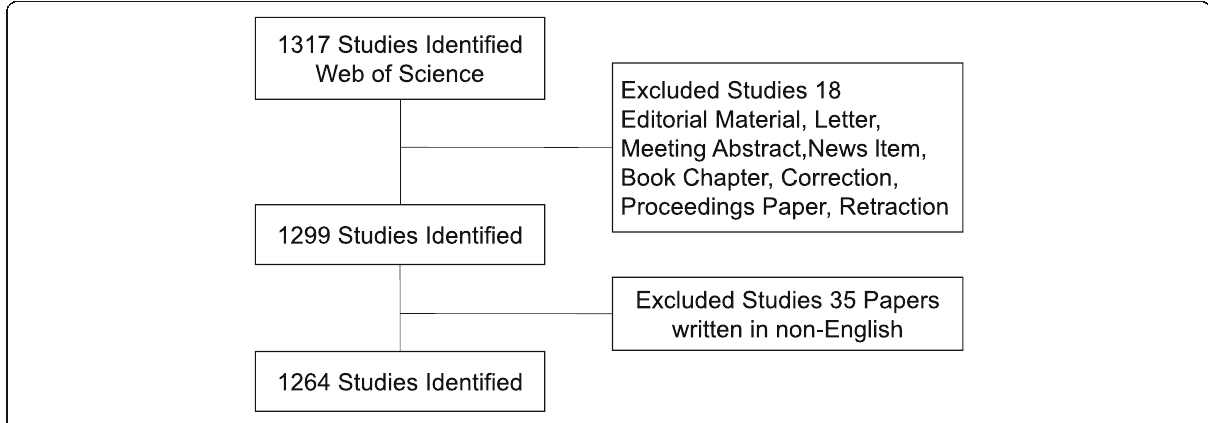
Fig. 1 Flow diagram of UKA research